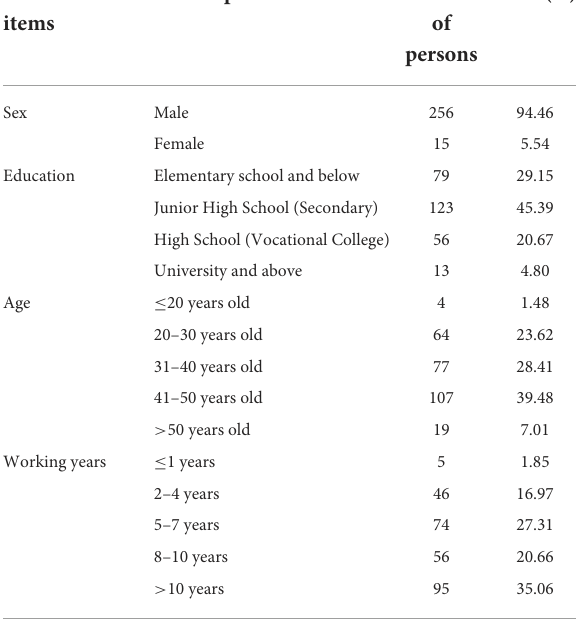
TABLE 1 Demographic information of the